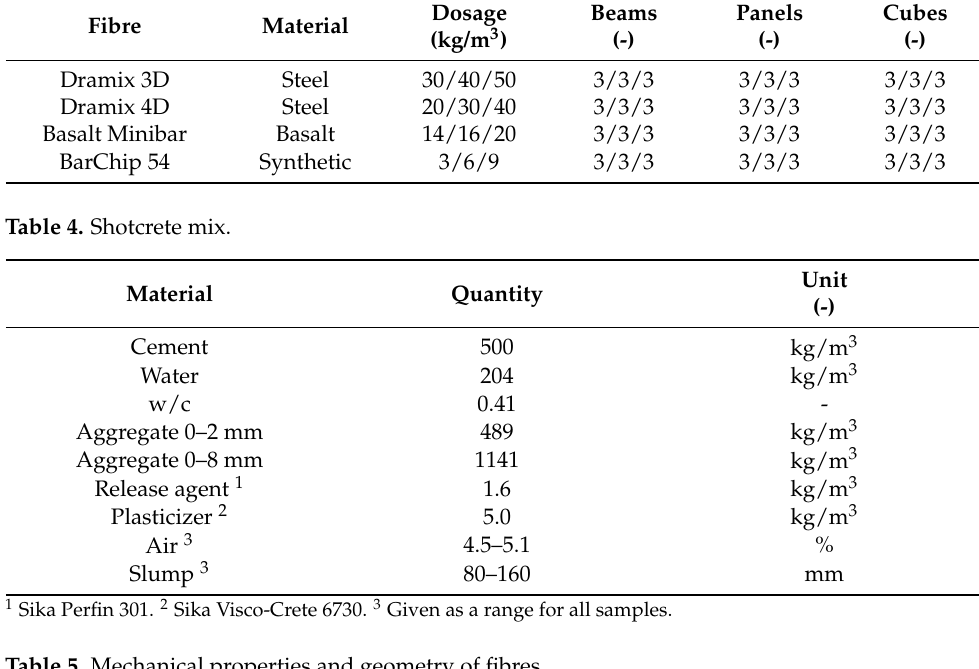
Table 3. Overview of experimental campaign.